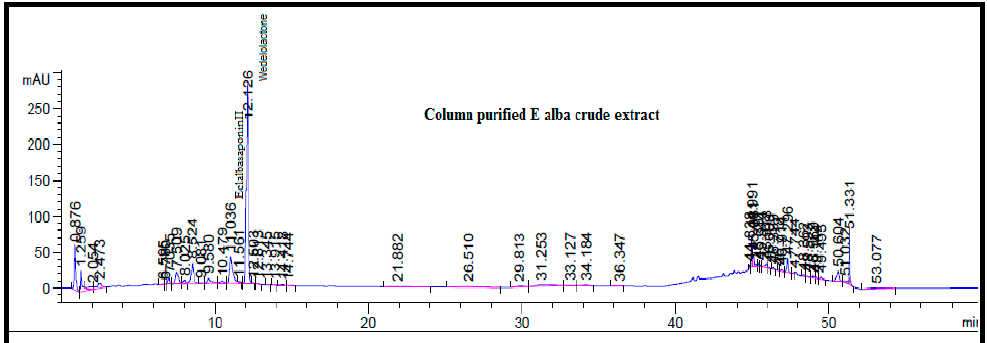
Figure 4. Ultra ‐ performance liquid chromatography (UPLC) Chromatogram profile of E. alba crude extract at 260 nm.